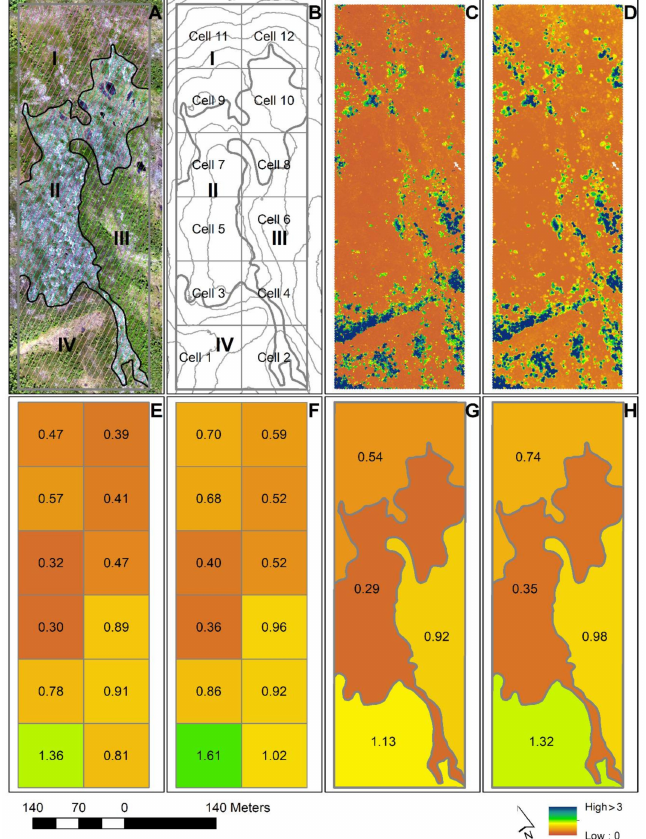
Figure 6. ( A ) Orthophoto of study area with manual delineation of the four sub-regions of Case B; ( B ) Map with 5 m counter lines, the 12 tessellated cells of Case A (Cell 1–12), and boundaries of the sub-regions for Case B (I–IV); ( C ) Predictions of vegetation height for the 1.5 m 2 population elements using ALS data; ( D ) Predictions of vegetation height for the 1.5 m 2 population elements using DAP data; ( E ) Estimated mean vegetation height using ALS data for tessellated cells of Case A; ( F ) Estimated mean vegetation height using DAP data for tessellated cells of Case A; ( G ) Estimated mean vegetation height using ALS for sub-regions of Case B; ( H ) Estimated mean vegetation height using DAP for sub-regions of Case B. The vegetation height estimates for each domain in Figures ( E – H ) are given by